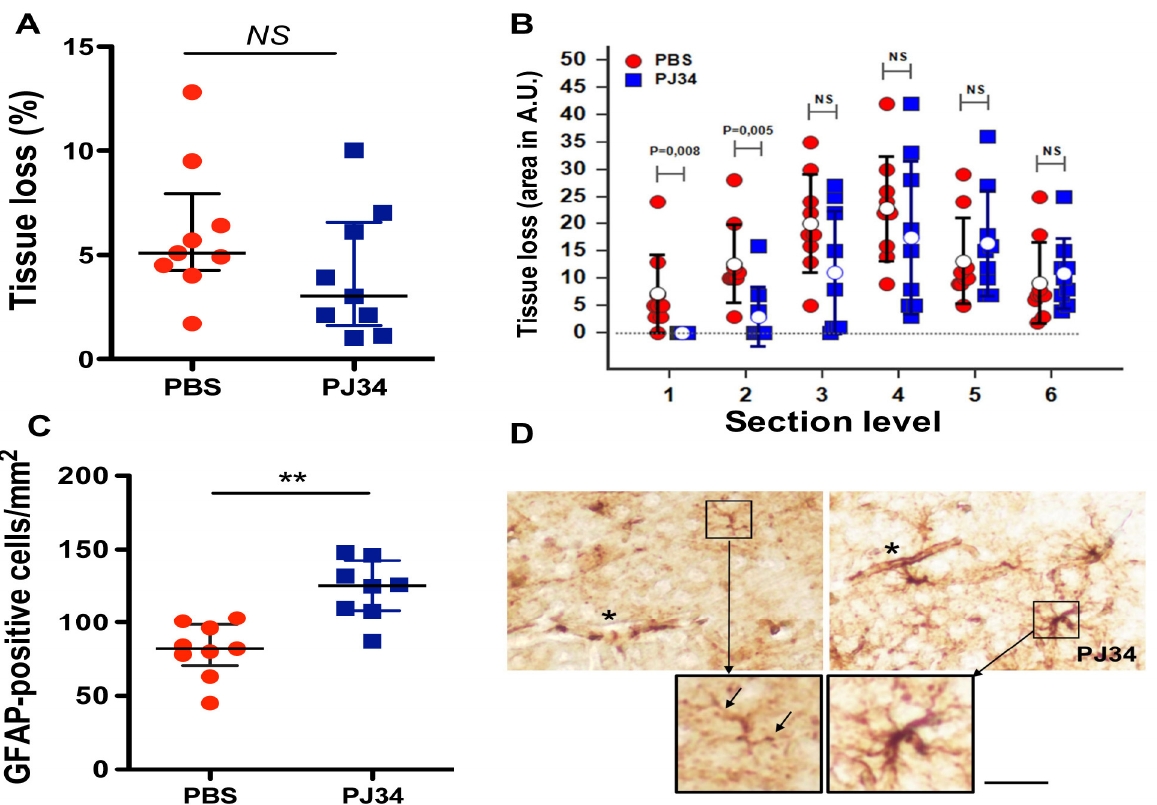
Figure 5. Tissue loss and astrocyte features eight days after ischemia were measured on the same mice used for the measurements of mBFV. ( A ): Total tissue loss in PBS- and PJ34-treated mice. ( B ): Tissue loss measured on six different brain levels (bregma 0.86 (1), 0.14 (2), − 0.80 (3), − 1.50 (4), − 2.30 (5), and − 2.92 (6) mm) from rostral to caudal brain. Whereas total tissue loss was not significantly reduced, a significantly reduced area of tissue loss was observed at the level of the two first sections (anterior striatum). Open circles represent the mean ± SD (black, PBS; blue, PJ34). NS = non-significant. ( C ): Quantification of GFAP-positive astrocytes in the cortex (bregma +0.14 mm) in PBS (red) and PJ34-treated (blue) mice. Data are plotted as dots with median and interquartile range, ** p < 0.01. ( D ): Representative images of astrocyte morphology in a PBS-treated and PJ34-treated mouse showing loss (in PBS) and presence of GFAP-stained astrocytes endfeet (black star) respectively, and a few astrocytes with clamatodendrotic features (black arrows in enlarged panel). In a PJ34-treated mouse, stellar GFAP-stained astrocytes with more or less thick processes (enlarged panel) were observed. Bar represents 20 µm.